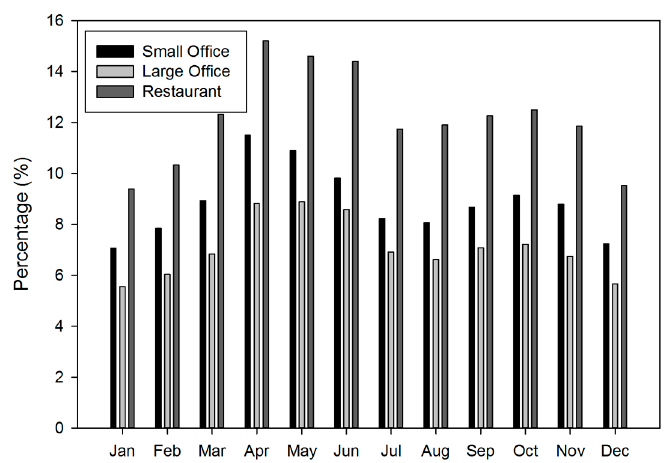
Figure 4. Number of hours that energy is supplied by the battery to each of the evaluated buildings in one year.